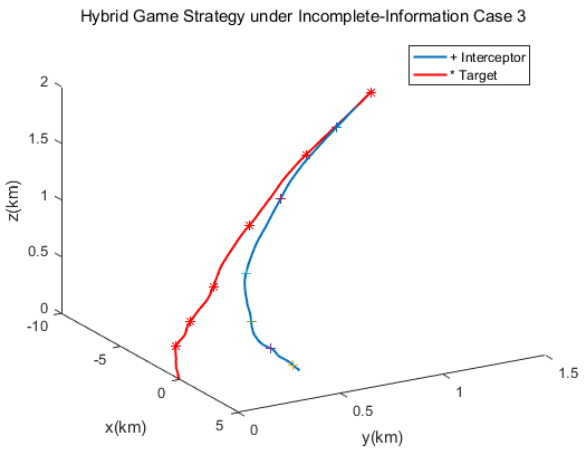
Figure 17. Spacecraft trajectories of the hybrid game strategy.